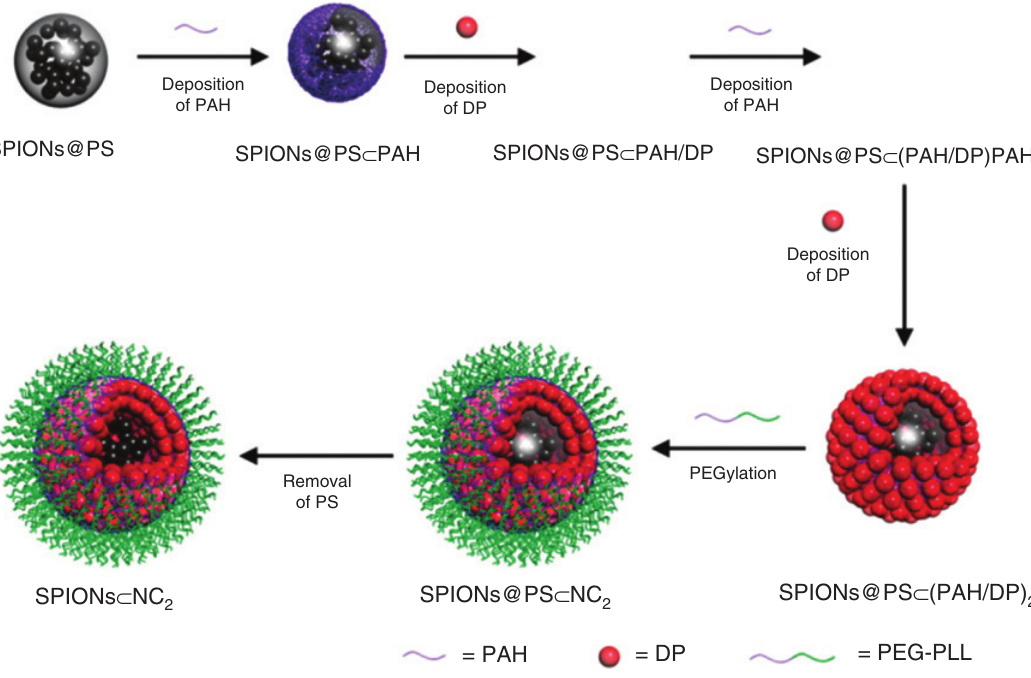
Figure 3: Preparation procedures for the fabrication of multifunctional hollow polymeric NCs made from SPIO NP and DP via the LbL method. Reproduced from Ref. (58). Copyright ©2014, American Chemical